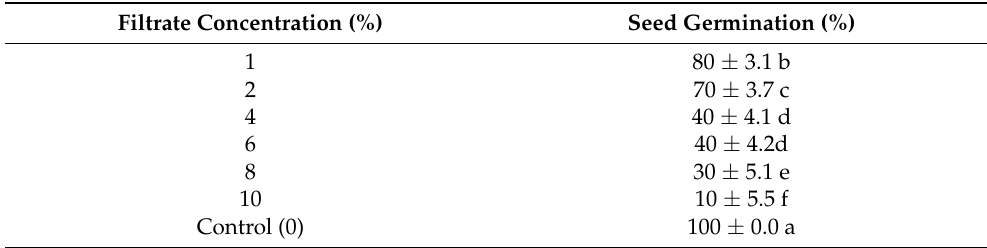
Table 2. Effect of Fusarium oxysporum KENF7 culture filtrate (different concentration 1–10%) on the seed germination of Baladi cumin in